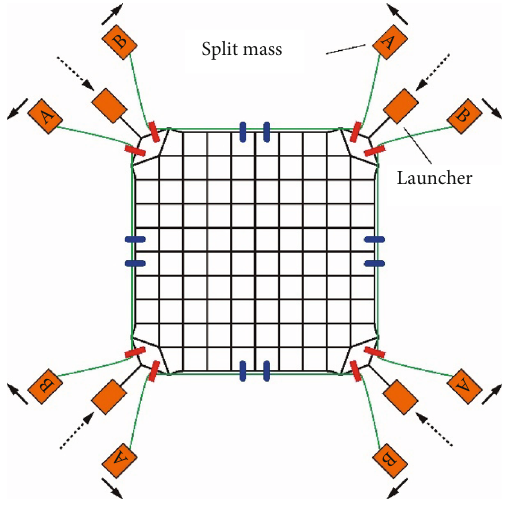
Figure 3: The tether-net after the beginning of